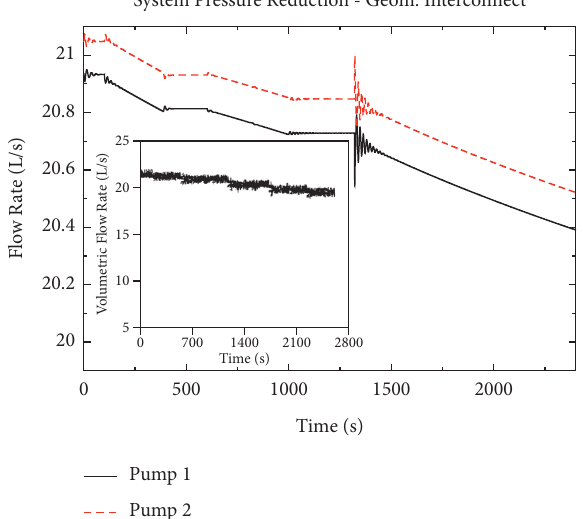
Figure 37: Flow oscillations resulting from system pressure reduction with geometric similarity